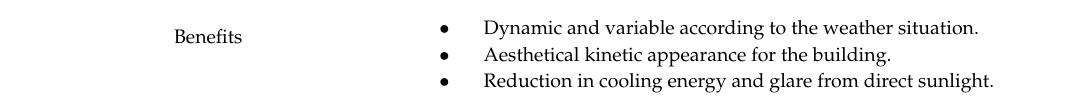
Table 4. Carrier systems of shading